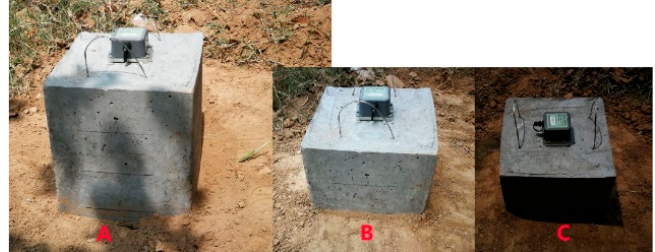
Figure 5. Perilous rock test models.